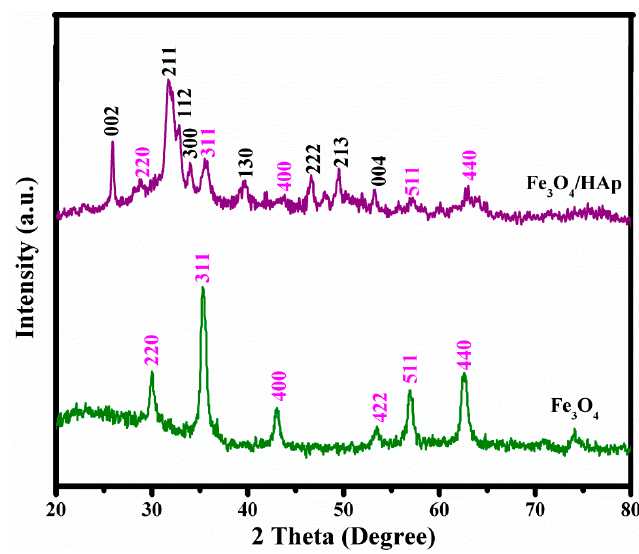
Figure 1. X-ray diffraction patterns of Fe 3 O 4 nanoparticles and Fe 3 O 4 nanoparticles on hydroxyapatite nanorod based nanostructures (Fe 3 O 4 /HAp) nanocomposites.